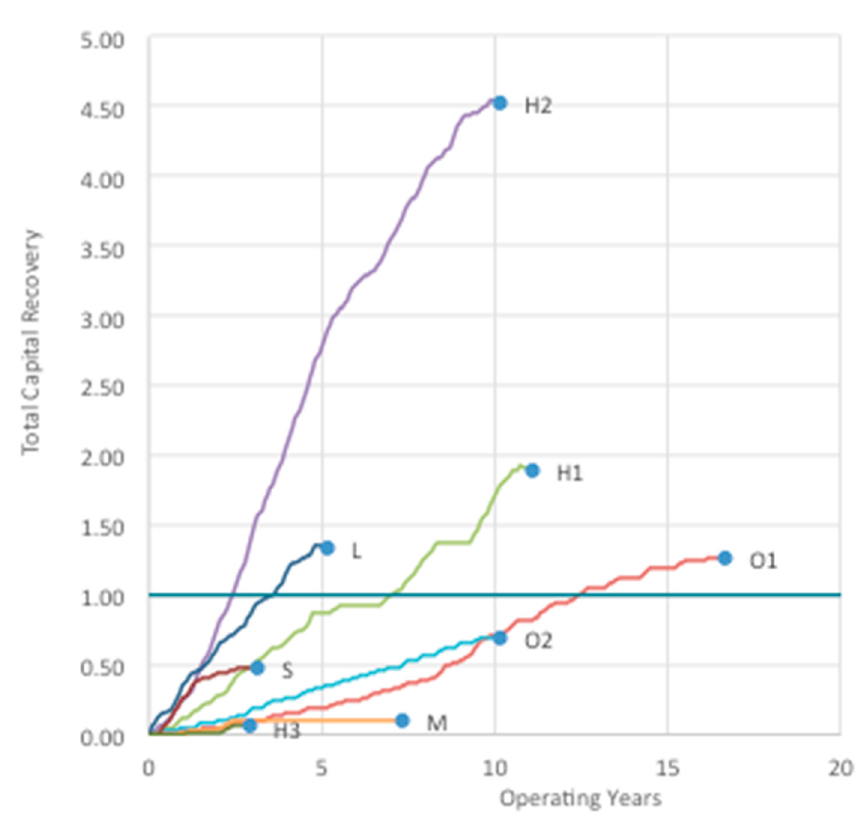
Figure 5. Comparison of total capital recovery 𝐶𝑅 (cid:3021) evolution for the eight Athens CHP